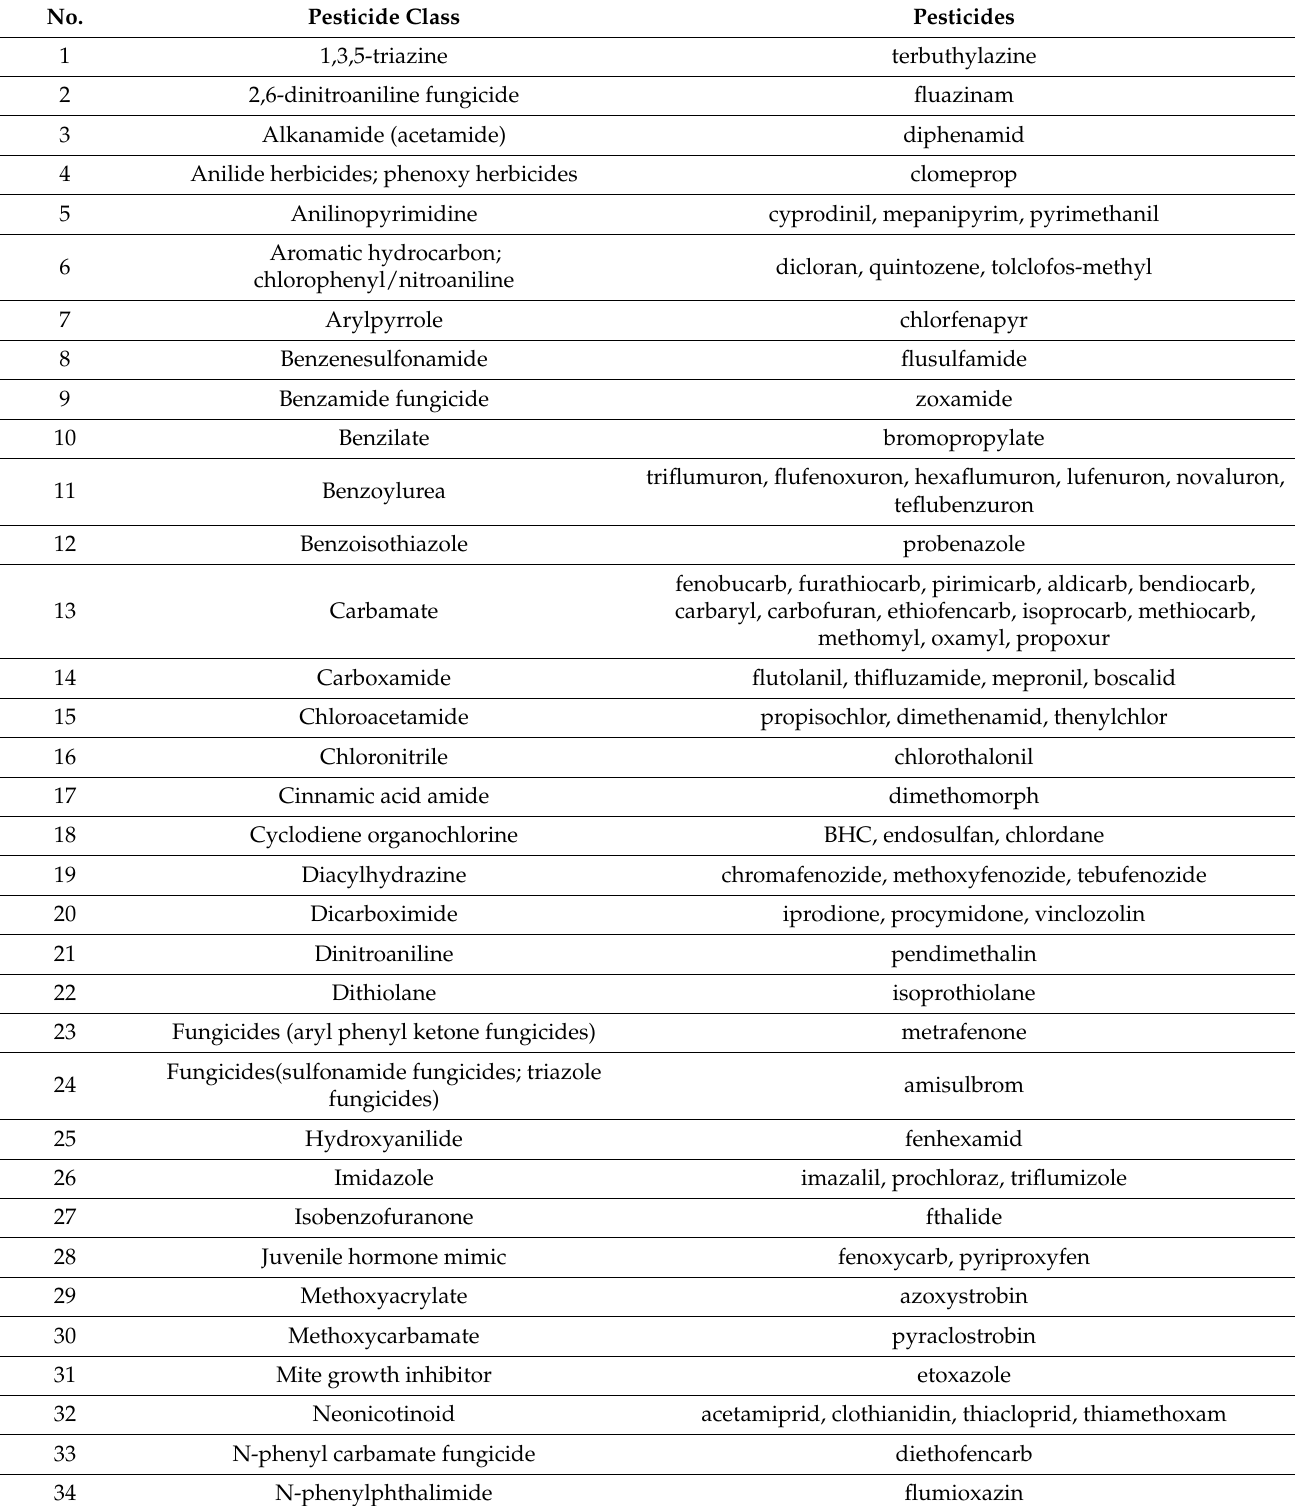
Table 2. Pesticides examined in our study (classified by pesticide